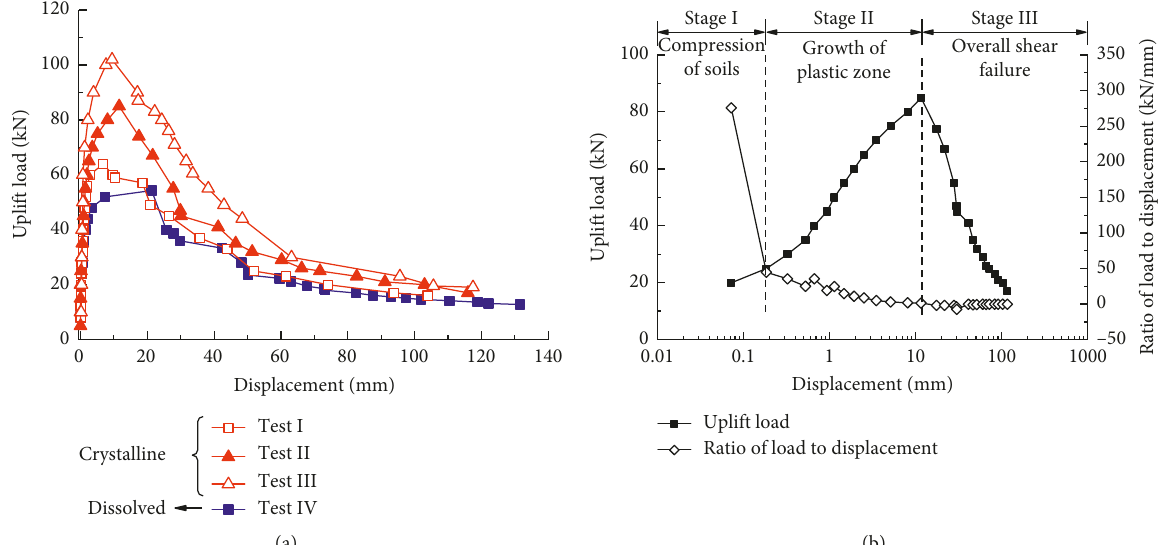
Figure 8: Uplift load-displacement curve of belled pier foundations. (a) Load-displacement relationship. (b) Ratio of load to